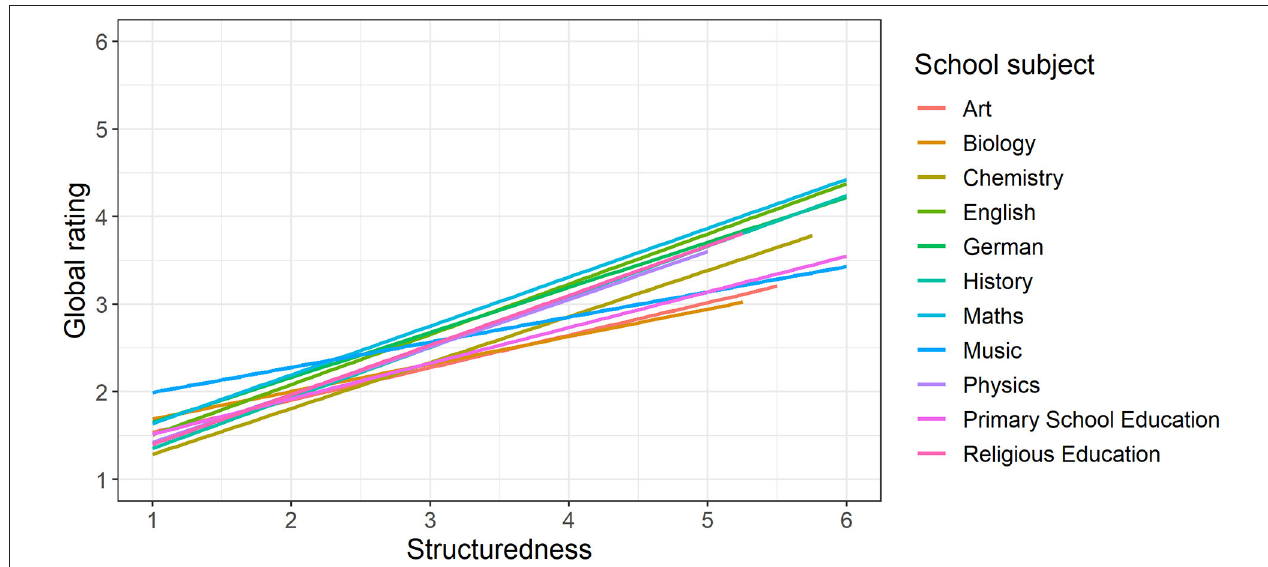
FIGURE 2 | Line graph of the subject-specific relationships between structuredness and global rating. Scaling of structuredness and global rating 1 6 =